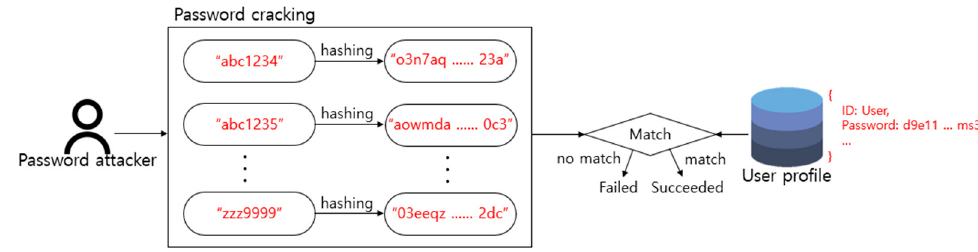
Figure 1. Brute-force password cracking process.